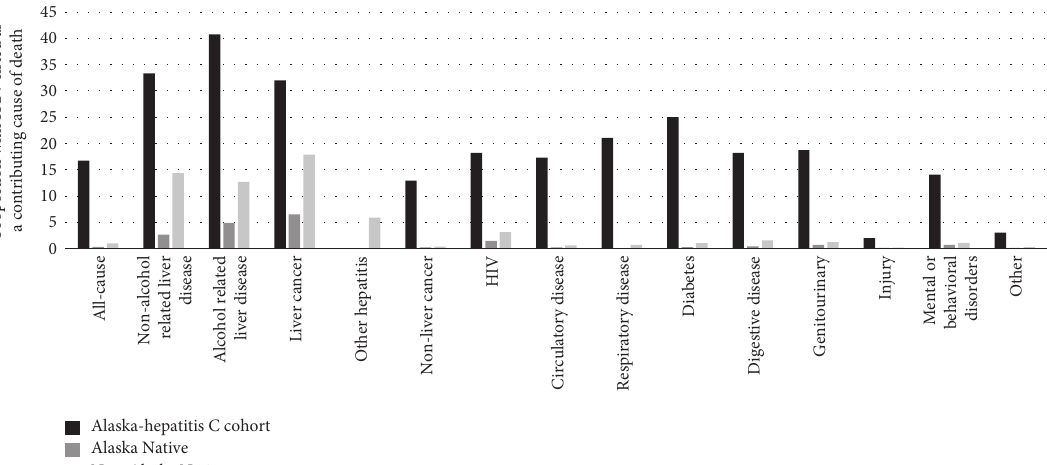
Figure 2: Proportion of death category with hepatitis C virus infection listed as a contributing cause of death among the Alaska-hepatitis C cohort and Alaska Native and Nonnative-Alaskan adults in Alaska,